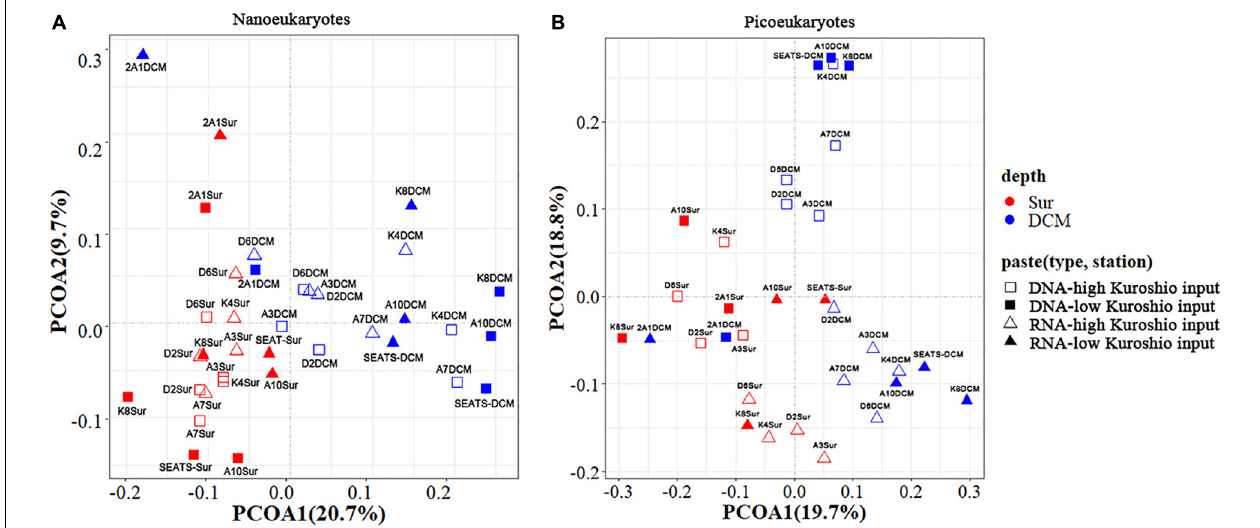
FIGURE 4 | Principal coordinate analysis (PCoA) of nanoeukaryotes (A) and picoeukaryotes (B) in all samples based on the Bray-Curtis distance matrix. Red color: the surface samples; Blue color: the DCM samples.